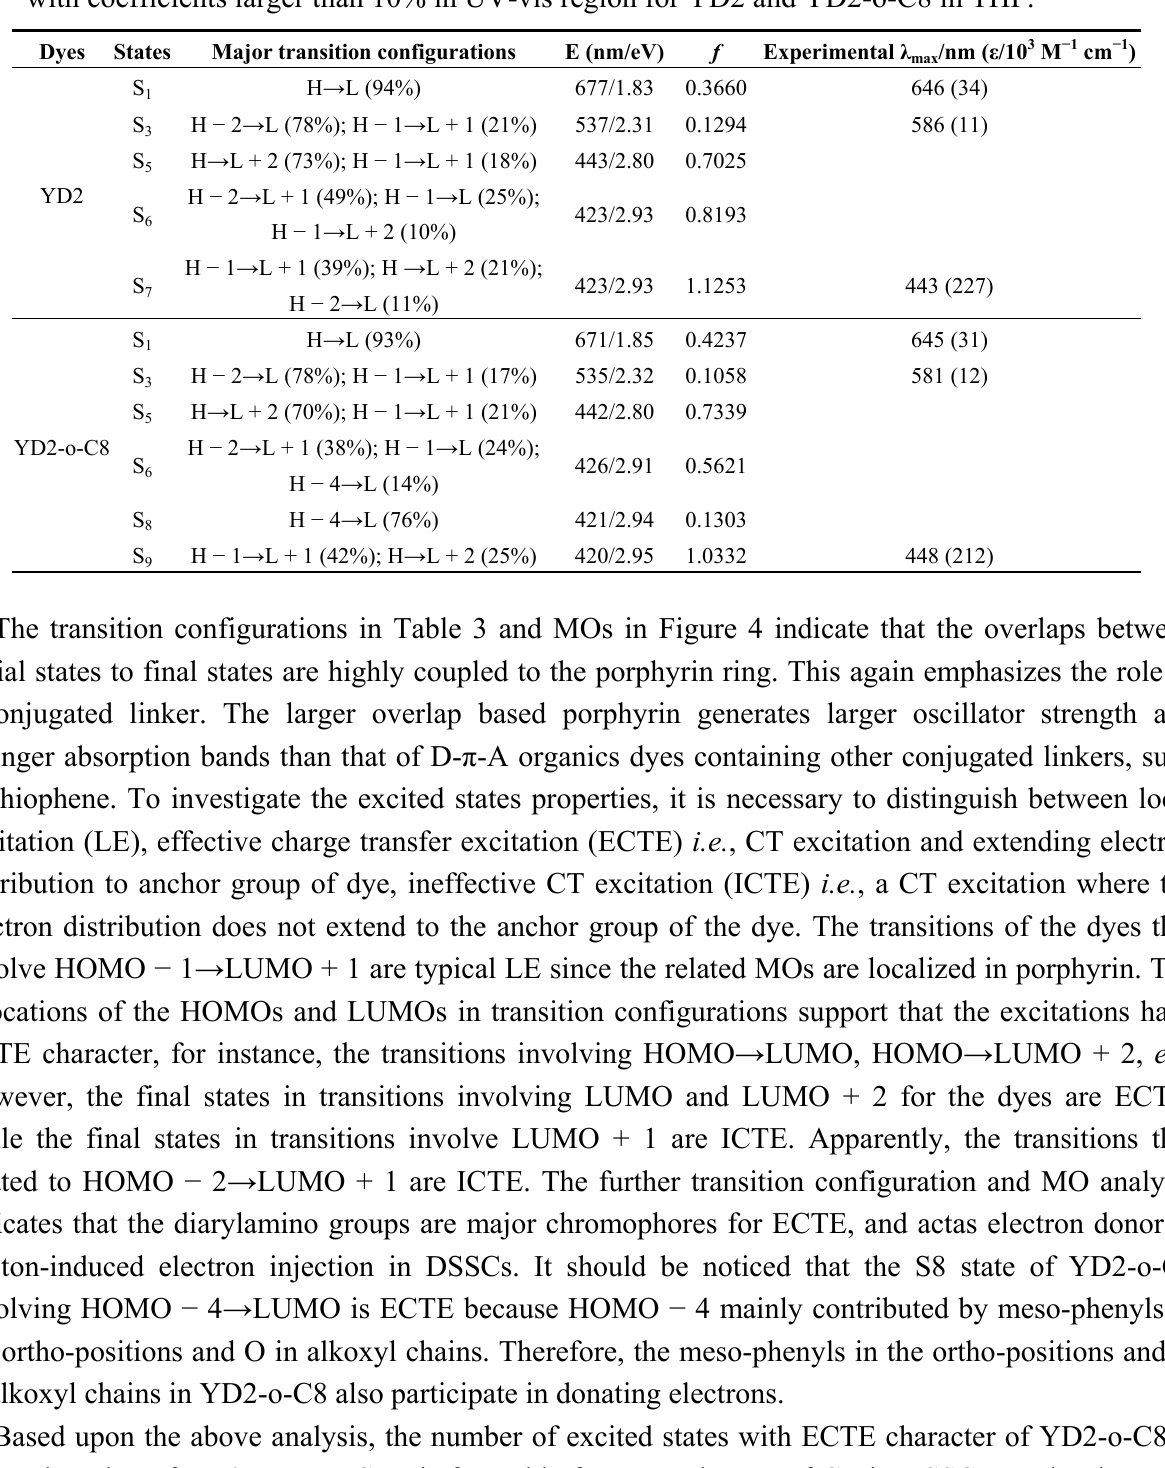
Table 3. The experimental spectra data and the HSE06 functional calculated excitation energies (eV), wavelength (nm), oscillator strengths (f) and major transition configurations with coefficients larger than 10% in UV-vis region for YD2 and YD2-o-C8 in